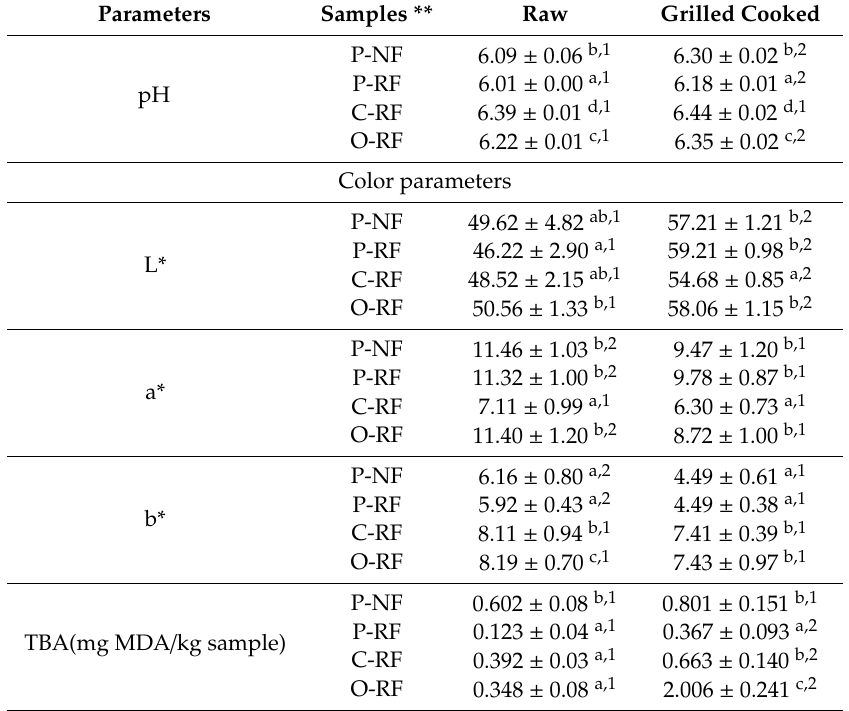
Table 2. pH values, color parameters ((L*) lightness, (a*) redness and (b*) yellowness)) and thiobarbituric acid-reactive substances values (TBARs) (expressed as mg MDA / kg sample) of raw and grilled cooked